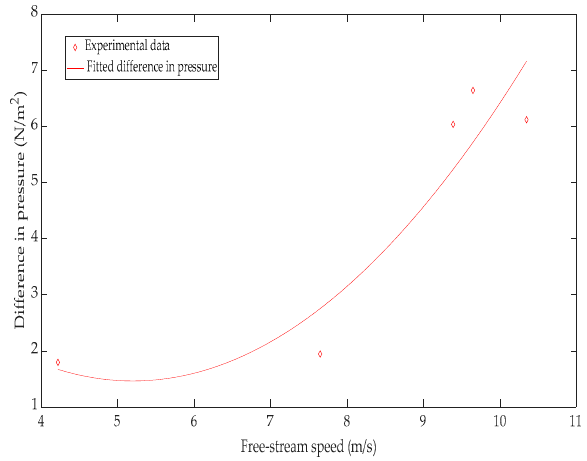
Figure 6. Difference in pressure as a function of the free-stream speed. Figure 6. Di ff erence in pressure as a function of the free-stream